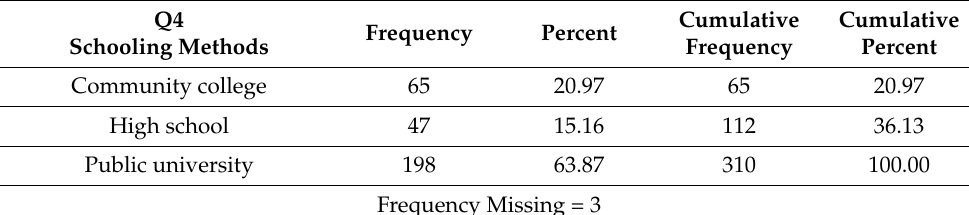
Table 4. Frequency for